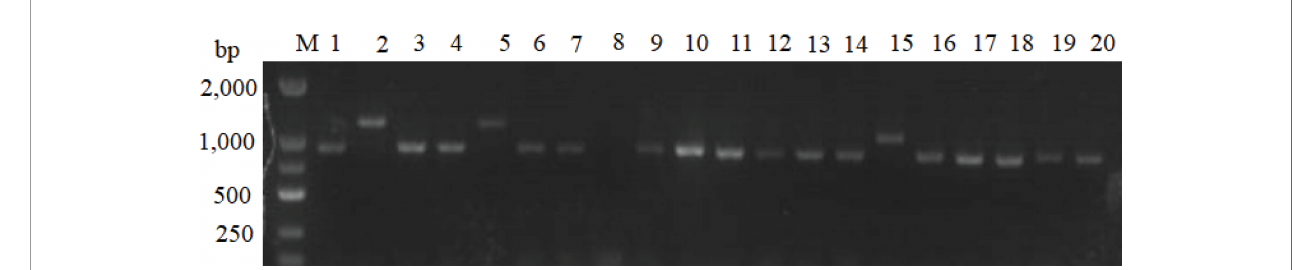
FIGURE 13 | Veri fi cation of positive colonies by PCR. M: DL2000 Marker. 1-20: PCR veri fi cation of positive yeast colonies.